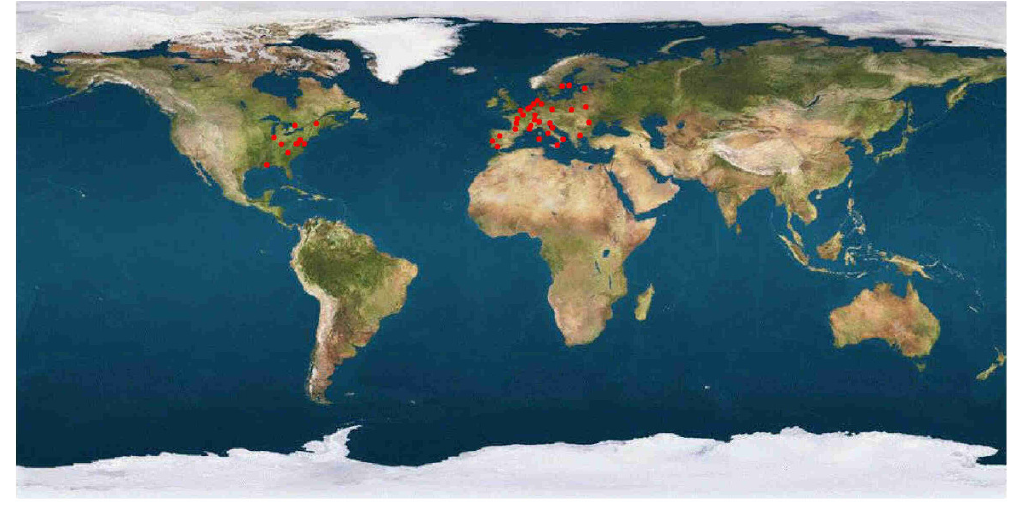
Fig. 17. Location of validation sites of AERONET, used for the inter-comparison of AOT retrievals from MERIS L1 data with ground based measurements of